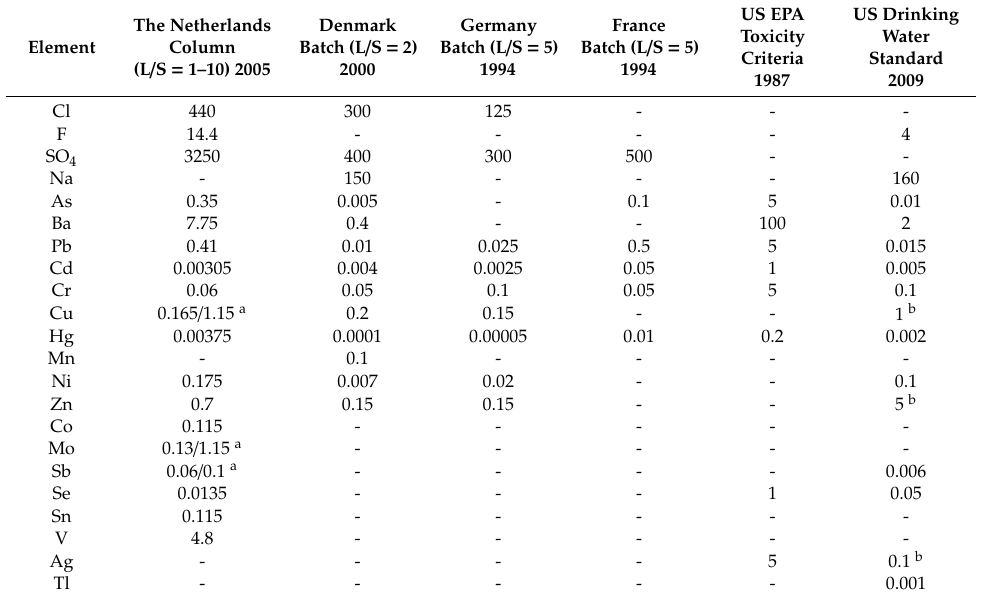
Table 7. Leaching criteria for di ff erent constituents from MSWI BA residue for utilization in various countries (mg / L)